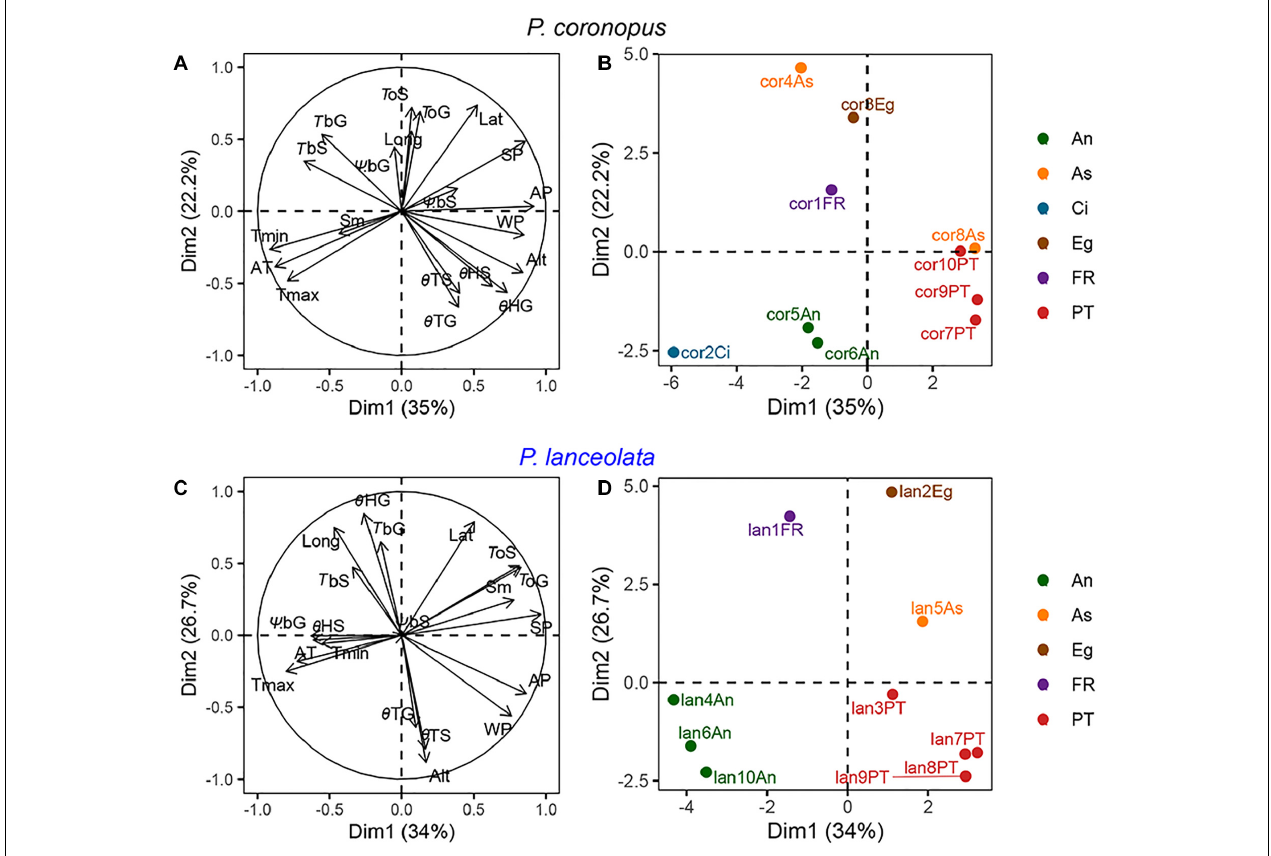
FIGURE 3 | Factor analysis of mixed data (FAMD) analysis with species as categorical variables and physiological traits, provenance climate conditions, and geographical coordinates as continuous variables. (A,C) display the quantitative variables that contribute to the total variance; (B,D) display accessions plotted by color-coded regions for P. coronopus and P. lanceolata , respectively. Each accession name contains a species code, accession number, and the region acronym. The environmental temperatures (T max , T min , and T a ), environmental precipitation (A p , S p , and W p ), geographical coordinates (Alt, Lat, and Long), physiological